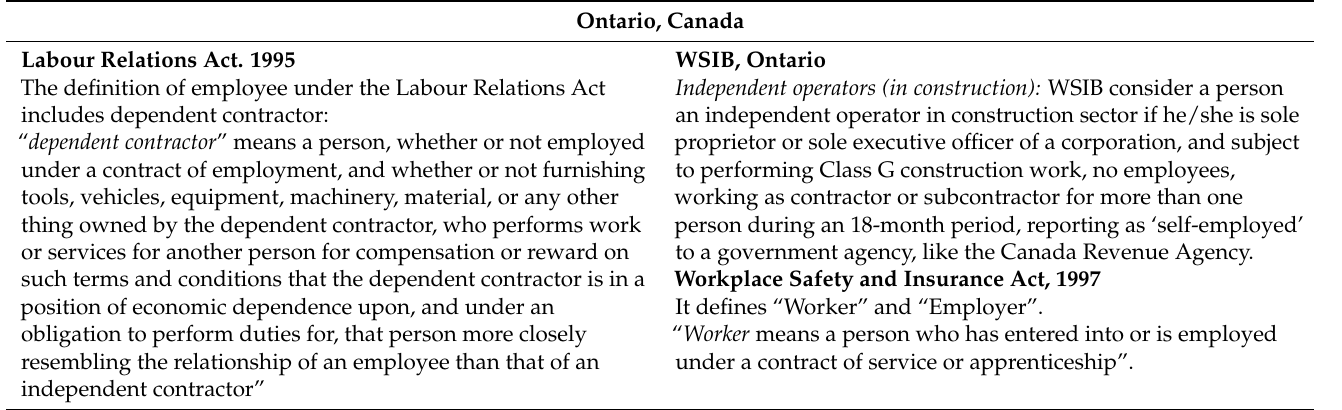
Table 3. Legal Frameworks addressing Self-employment.